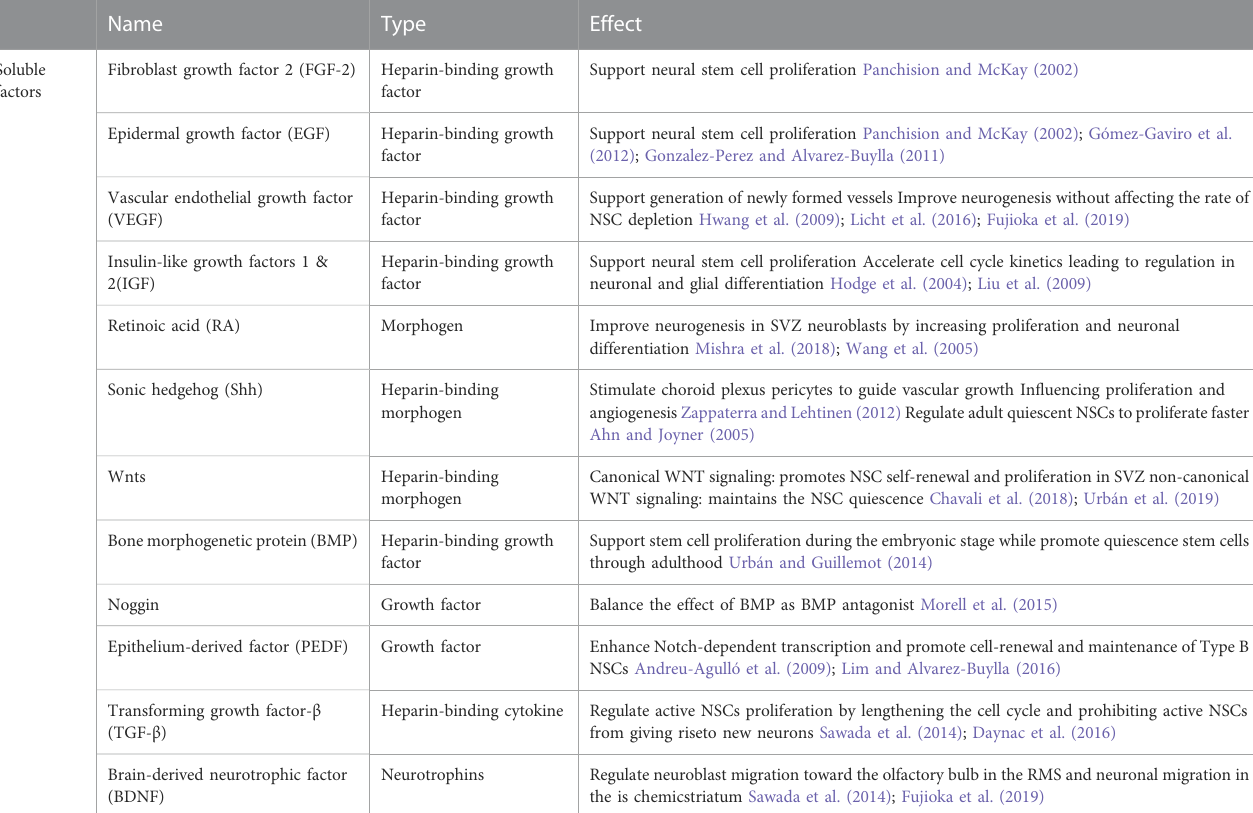
TABLE 1 Soluble growth factors within the neural stem cell niche contribute to neural stem cell maintenance and